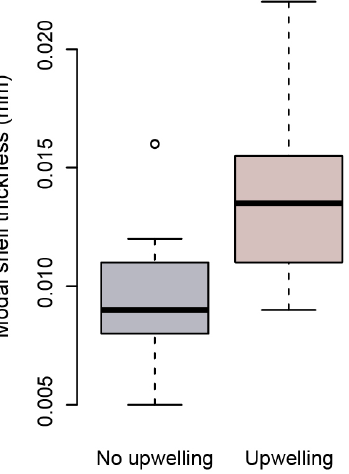
Figure 8. Modal shell thicknesses of specimens from times of upwelling (red) and times of no upwelling (grey) in the Cariaco Basin. Specimens collected during times of upwelling are signifi- cantly thicker than those which formed at times with no upwelling (Welch’s t test: p = 4 . 4 × 10 − 4 ).